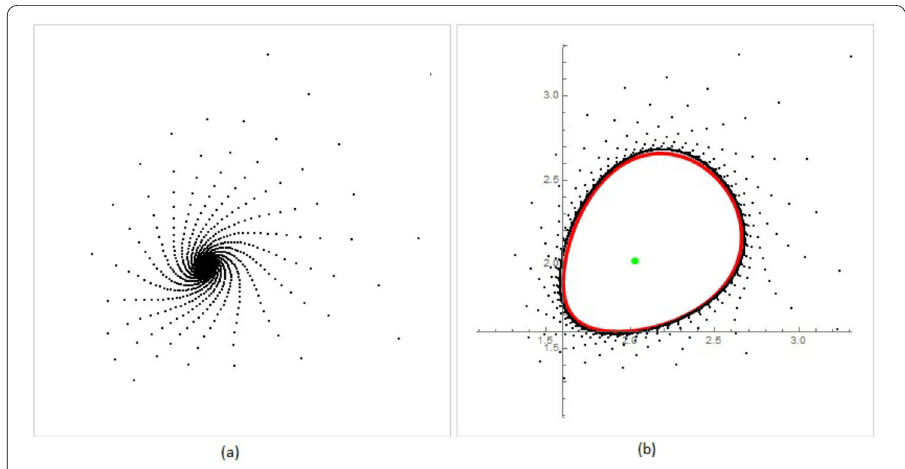
Figure 3 ( a ) Trajectory (black) for p = 1.99. ( b ) Trajectory (black) and asymptotic approximated invariant curve (red) for p = 2.01